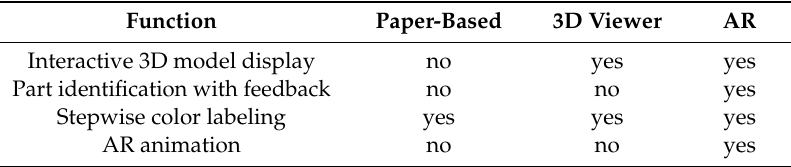
Figure 4. Two augmented reality (AR)-assisted systems. Table 1. Assisted functions provided by three media.